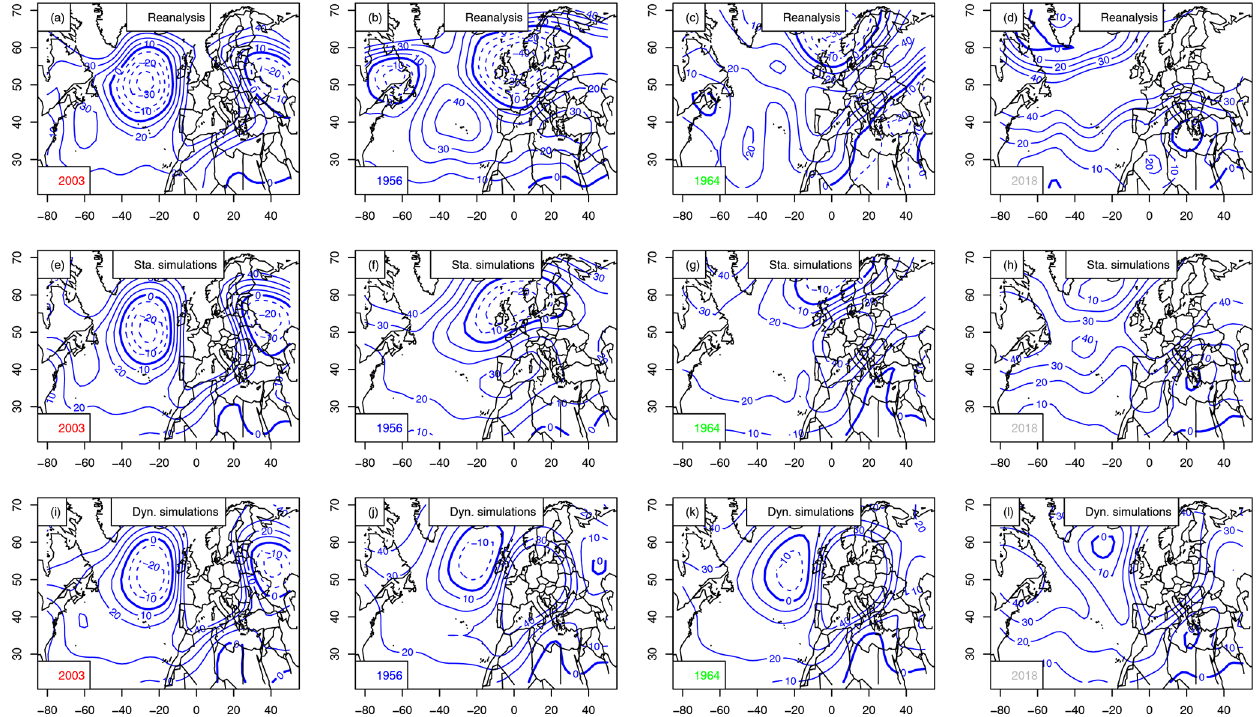
Figure B2. Z500 anomaly composites (in meters, with 10m increments) for the warmest summer in Orly (2003), coolest (1956), median (1964) and 2018. The 0m isoline is indicated with a thick blue line. Negative anomalies are in dashed isolines. Horizontal axes are for longitudes in degrees east. Vertical axes are for latitudes in degrees north. Upper row (a–d) : mean Z500 from NCEP reanalyses. Center row (e–h) : static simulations. Bottom row (i–l) : dynamic